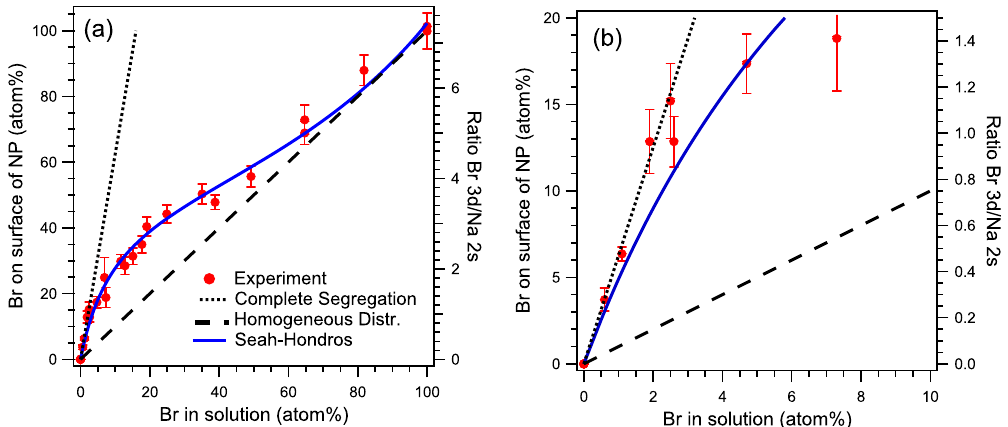
FIG. 3. Br = Cl ion surface ratios in d ¼ 70 -nm aerosols as a function of the Br = Cl atom ratio in the primary droplets. (a) Ratio of integrated Br 3d and Na 2s photoemission signals (right axis) and the resulting surface atom percentage as a function of the mixing ratio (left axis). The broken line represents a model with no surface segregation, and the dotted line represents a model with complete segregation (all bromine ions in the primary droplet end up in the surface region of the solid aerosol — see text). The blue curve is based on a fit to the Seah-Hondros theory of surface segregation. (b) Zoom-in of the low-mixing-ratio region where complete bromide surface segregation is